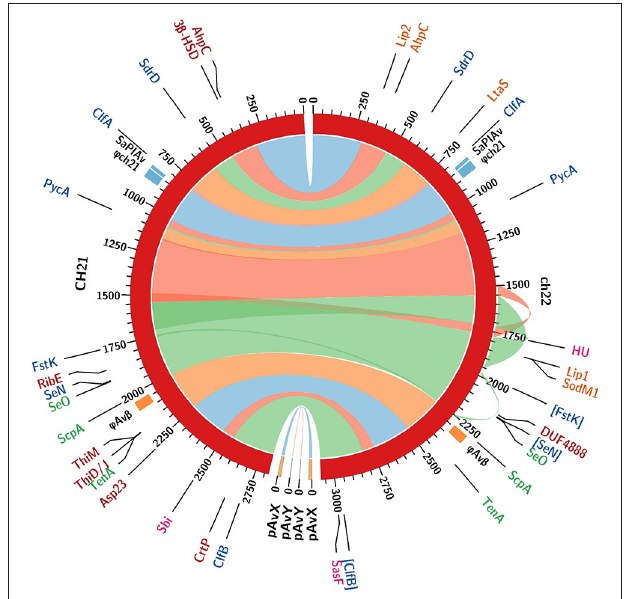
FIGURE 5 | Comparison of whole genome sequences of the CH21 and ch22 strains. Color bands represent continuous similar sequence segments characterizing the two strains. Particular segments are separated by short insertions or duplications unless indicated otherwise. Three longer duplications in the ch22 genome (170, 54, and 11 kbp) are additionally marked by outward ribbons. Loci of intrachromosomal mobile genetic elements, such as prophage ϕ Av β , putative prophage ϕ ch21 and pathogenicity island SaPIAv, are marked. The loci differentiating the two strains are identified with acronyms and colored as follows. Genomics: coding sequences in blue and promoters in green (pseudogenes in square brackets). Proteomics: intracellular in red; extracellular in orange; and surface in magenta (upregulated proteins